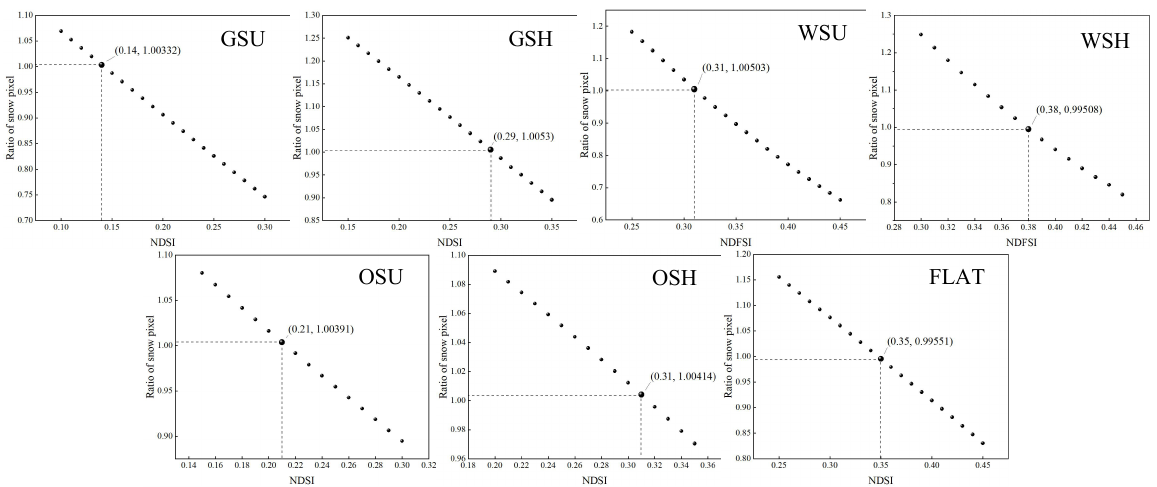
Figure 3 . Distribution of snow pixel ratio with thresholds in sentinel-2 snow map and “ true ” snow map. shows the snow cover results of the whole image extracted by the dynamic threshold method. Compared with the GF-2 snow map, the snow cover extracted by the dynamic threshold method is similar, and the visual results are better.